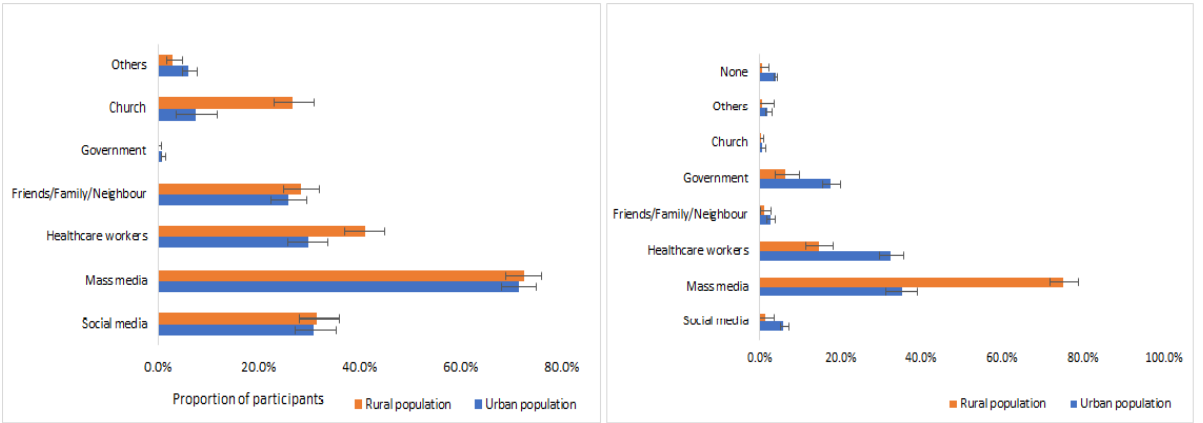
workers. A higher proportion of urban participants compared to rural participants trusted government or healthcare workers.